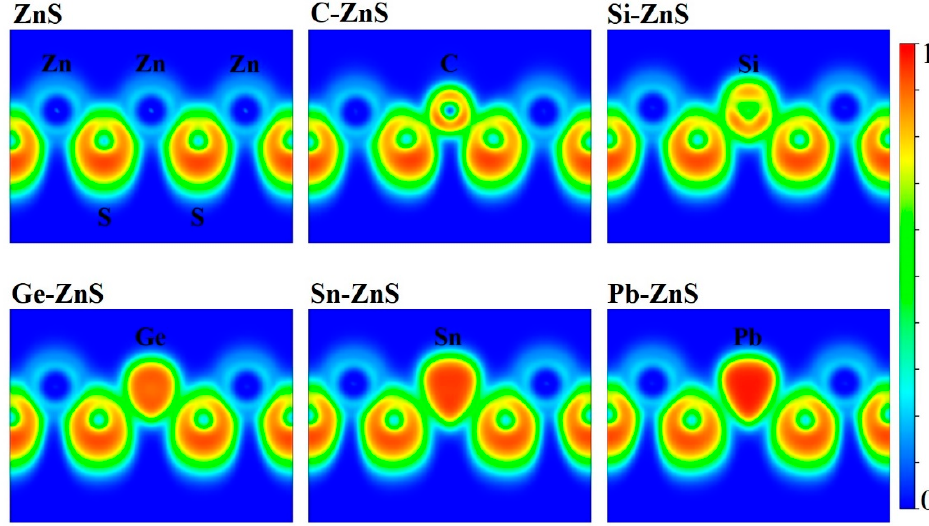
Figure 6. The electronic localization functions of ZnS and the doped models. Figure 7 plots the projected density of state (PDOS) of the ZnS monolayer, C − ZnS, Si − ZnS, Ge − ZnS, Sn − ZnS, and Pb − ZnS. For the PDOS of the ZnS monolayer, the valence bands near the VBM are predominantly composed of the p states of Zn and S, indicating that Zn and S atoms tend to form p-p bonds despite their tetragonal structure. The CBM is ascribed to the s states of Zn, which originate from the outer − shell electron due to the high energies. When doping C into the ZnS monolayer, the s states of C and p states of S are generated above the valence band of the ZnS monolayer, and the p states of C are observed below the conduction band of the ZnS monolayer, resulting in a smaller band gap. The s states of the C and p states of S near the VBM form an sp 3 hybrid interaction, resulting in the C − centered tetrahedron. The PDOS of monolayer Si − ZnS, Ge − ZnS, Sn − ZnS, and Pb − ZnS present similar electronic structures. The valence band structure is composed of two parts: one is the contribution from the Zn and S atoms resembling the ZnS monolayer, and the other is ascribed to the contribution from S and the doping atoms (Si, Ge, Sn, and Pb), in which the s states of the doping atoms and the p states of S atoms probably form the sp 3 hybrid bonds. The conduction band structures of these models are similar to that of the ZnS monolayer, in which the CBM mainly comprises the s state of the Zn atom. Compared to the PDOS of the ZnS monolayer, it is clear that the group − Ⅳ A elements doping to the ZnS monolayer usually reduce the band structure by generating sp 3 hybrid states in the band structure with higher energies. The prominent variance is probably due to the two extra valence electrons in the group − Ⅳ A elements, which vary the bonding nature in doped the ZnS monolayer.